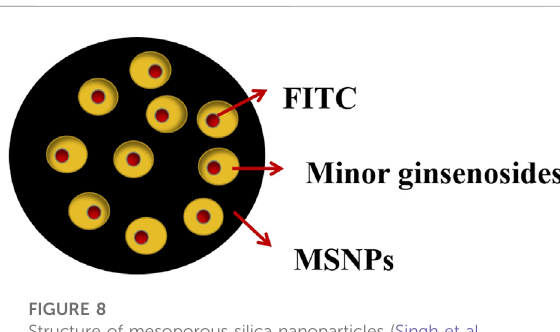
FIGURE 8 Structure of mesoporous silica nanoparticles (Singh et al.,